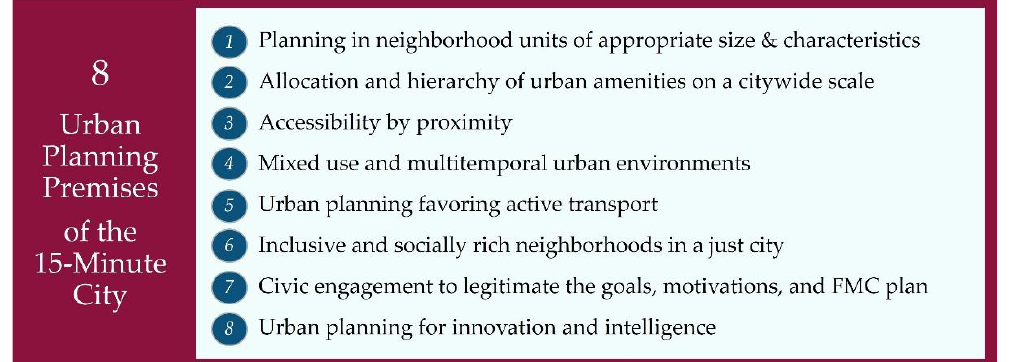
Figure 1. The eight urban-planning premises of the 15-minute city (authors).